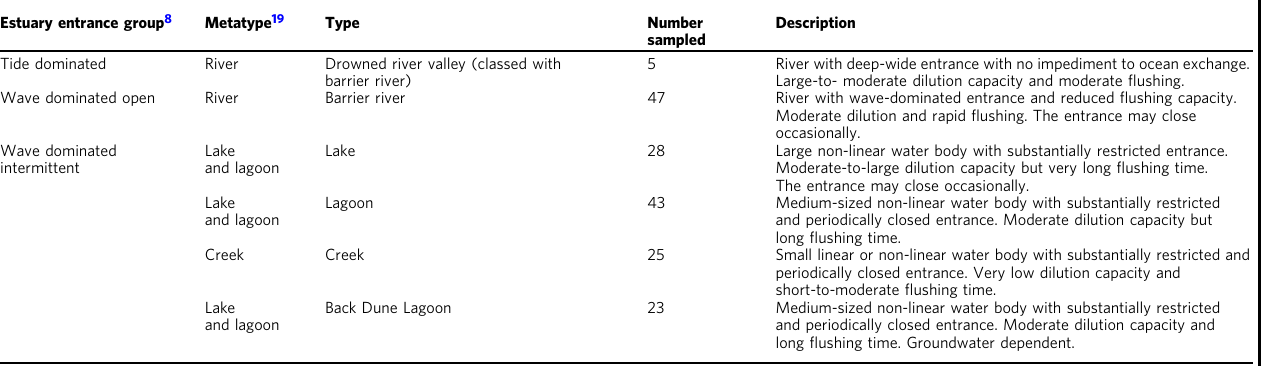
Table 4 Generalised characteristics of NSW estuary